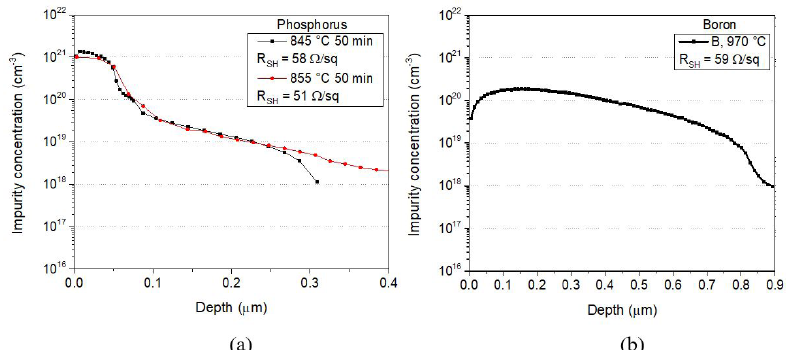
Figure 3. (a) Phosphorus and (b) boron impurity concentration obtained by